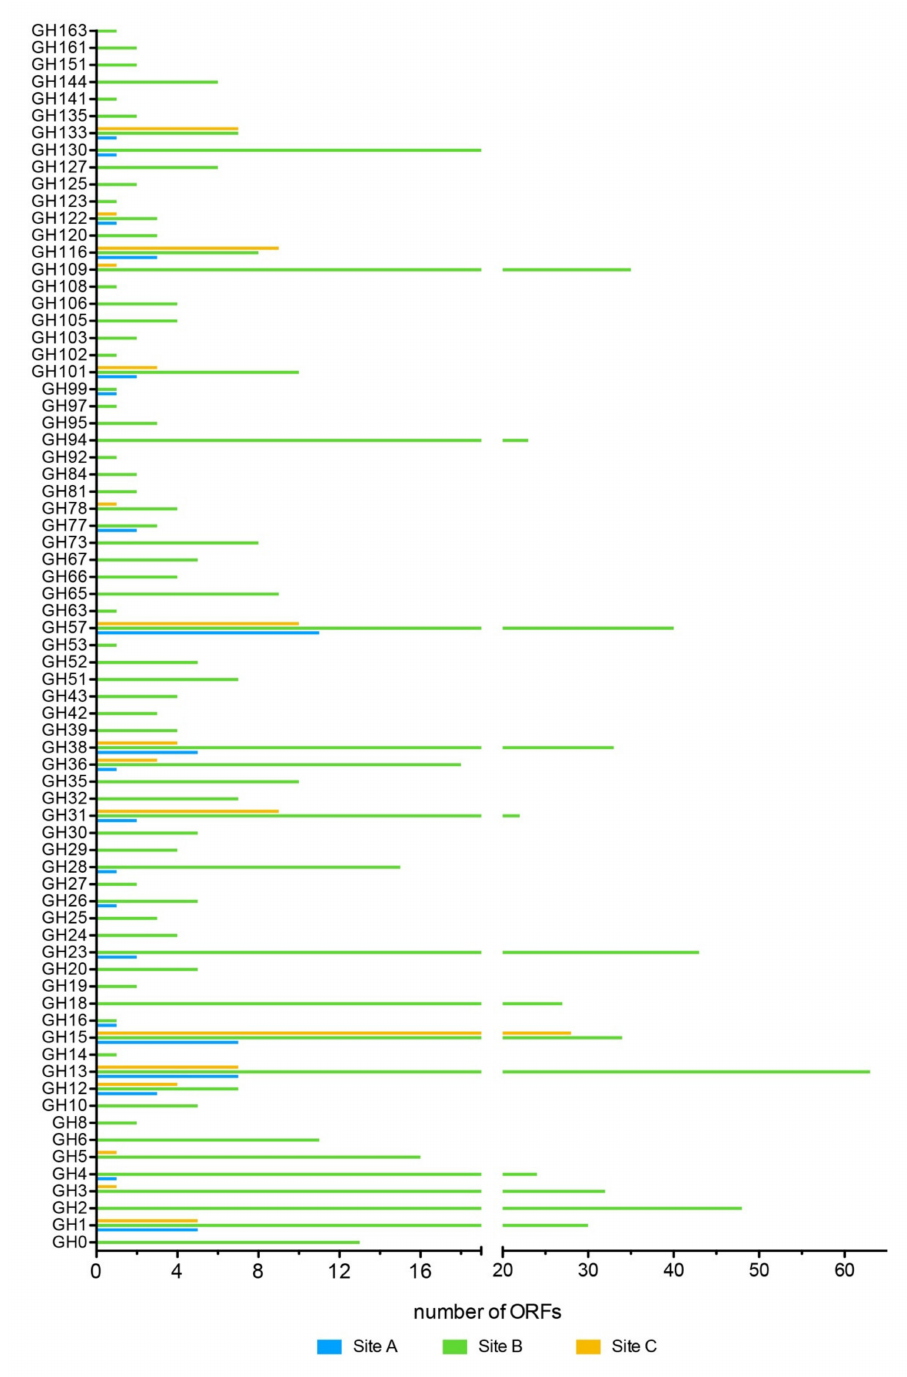
Figure 10. Distribution of glycosidases among the sites A, B, and C. The ORF number assigned to GHs from each sample is